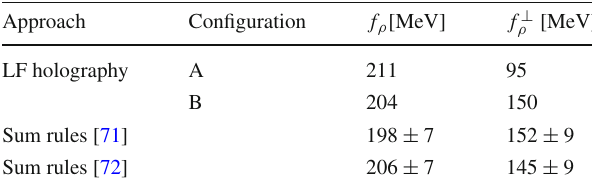
Table 5 Predictions for the ρ decay